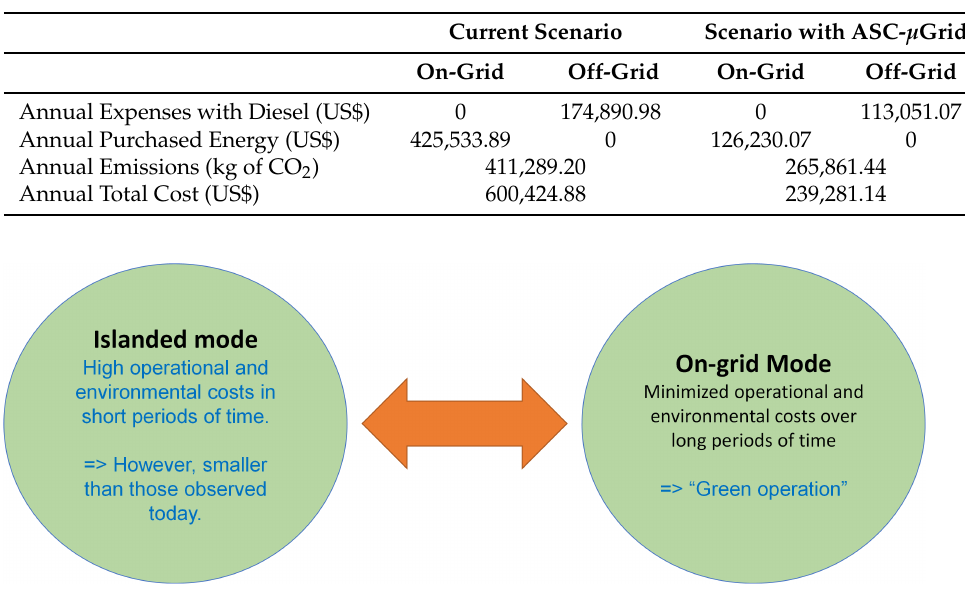
Table 2. Estimated earnings with the microgrid.